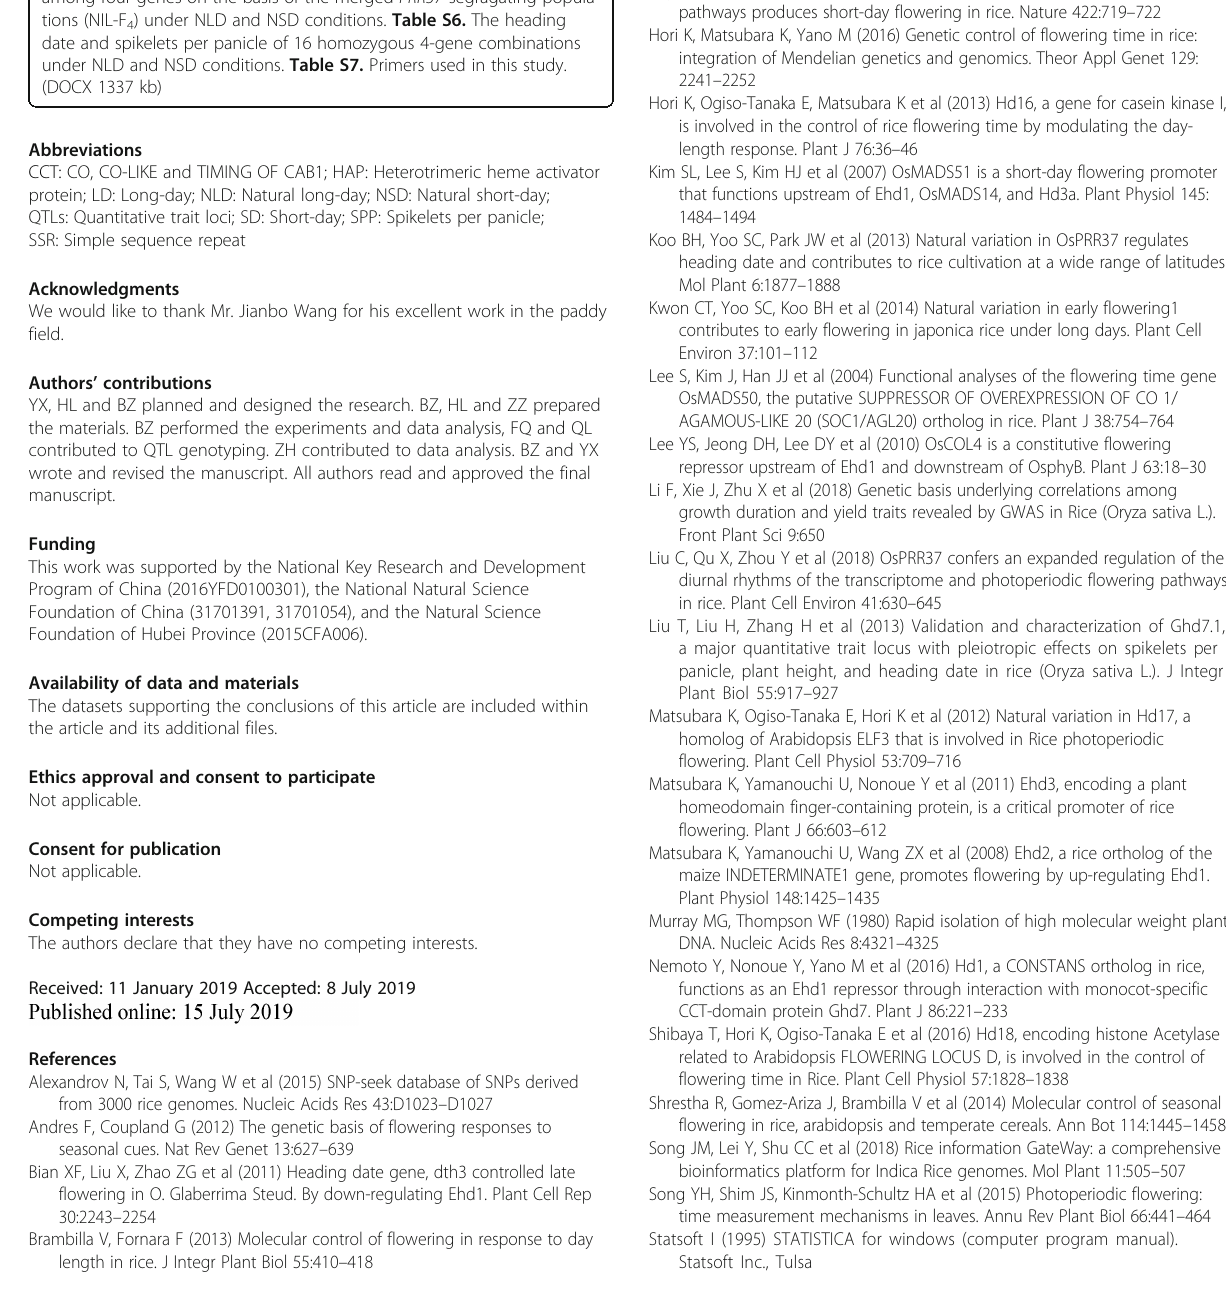
Additional file 1: Figure S1. Development and genome composition of the rice populations. Figure S2. Genetic interaction analysis among Ghd7 , Ghd8 , PRR37 and Hd1 in the 4-gene segregating populations under NLD and NSD conditions. Figure S3. Genetic interaction analysis of Ghd7 , Ghd8 , PRR37 and Hd1 in the merged PRR37 -segregating populations (NIL- F Table S1. Characteristics of four heading date genes and linked markers. Table S2. The monthly average day length of growing seasons at Wuhan and Lingshui. Table S3. Haplotypes of 10 heading date genes in ZS97. Table S4. The genetic interactions in the 4-gene segregating populations under NLD and NSD conditions. Table S5. The genetic interactions among four genes on the basis of the merged PRR37 -segragating popula- tions (NIL-F 4 ) under NLD and NSD conditions. Table S6. The heading date and spikelets per panicle of 16 homozygous 4-gene combinations under NLD and NSD conditions. Table S7. Primers used in this study. (DOCX 1337